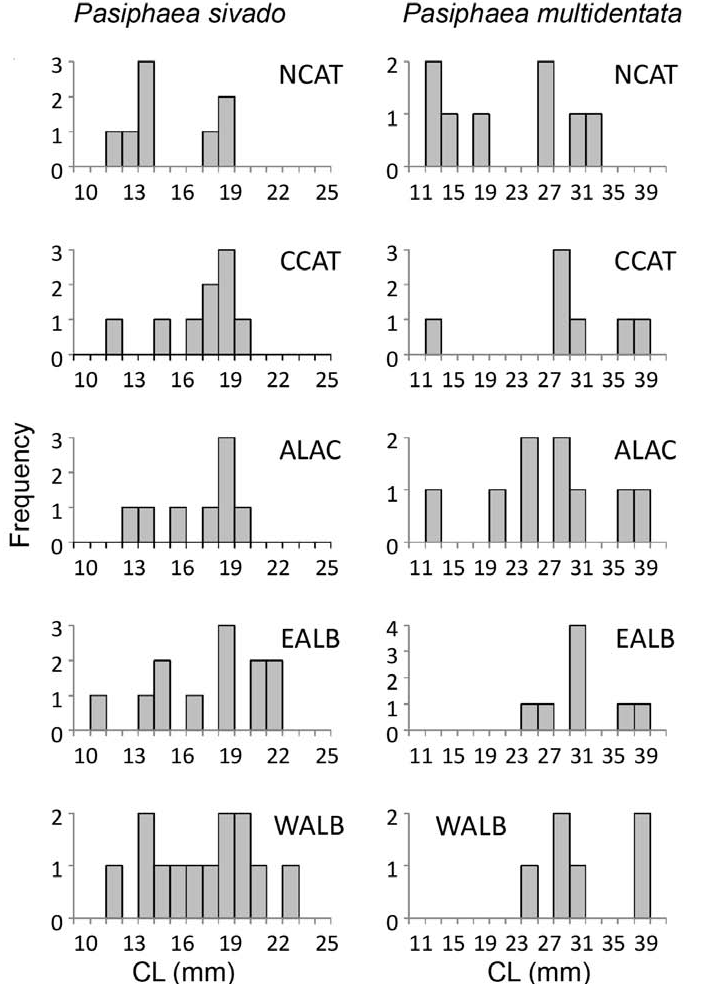
Fig. 3. – Frequency distribution of normally-distributed identified components in the size frequency distributions of Pasiphaea sivado and P. multidentata by geographic sector (NCAT, northern Catalonia; CCAT, central Catalonia; ALAC, Alacant; EALB, eastern Alboran; WALB, western Alboran). Size class intervals of 1 mm in P. sivado and 2 mm in P. multidentata